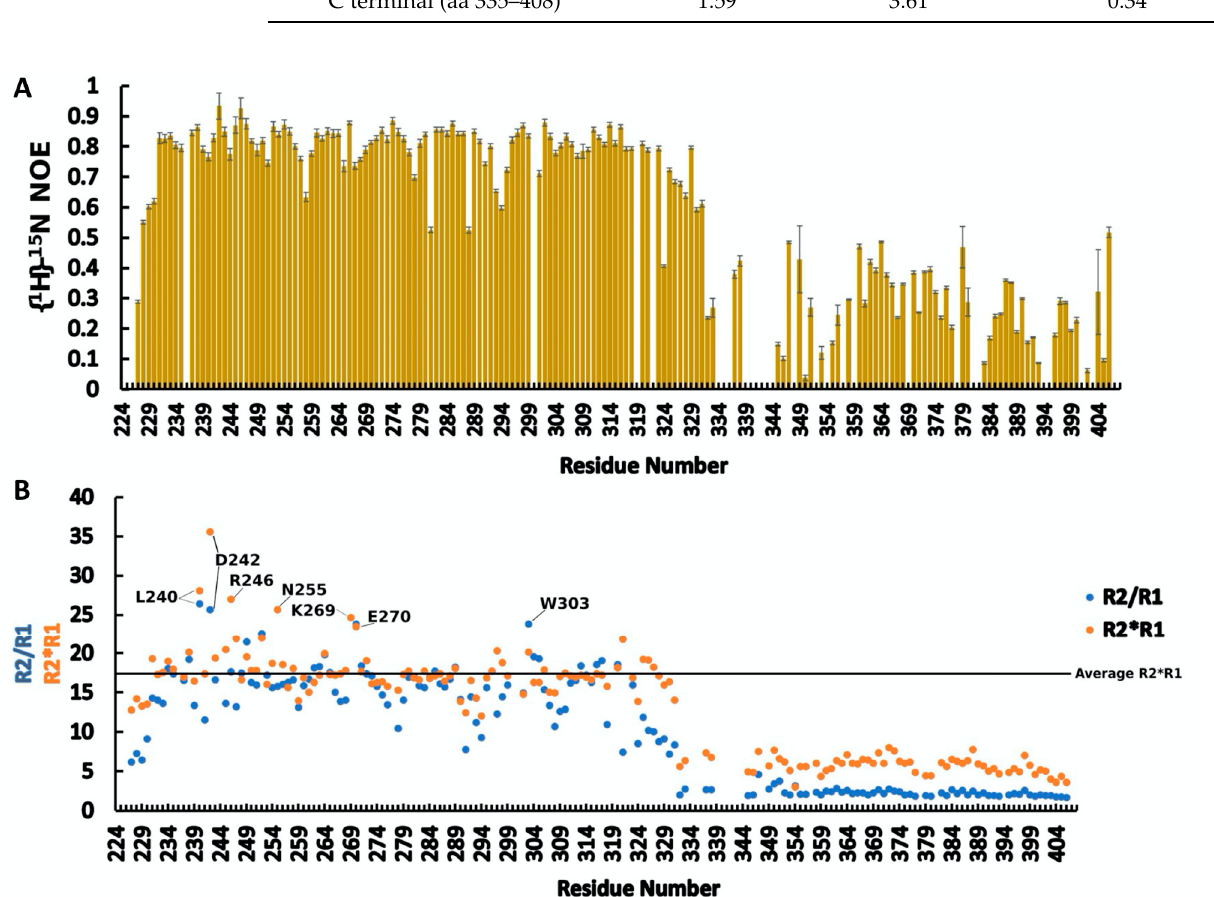
Figure 2. ( A ) heteroNOE values of RRM2-Cter (La 224–408); ( B ) R 2 /R 1 and R 1 × R 2 values of